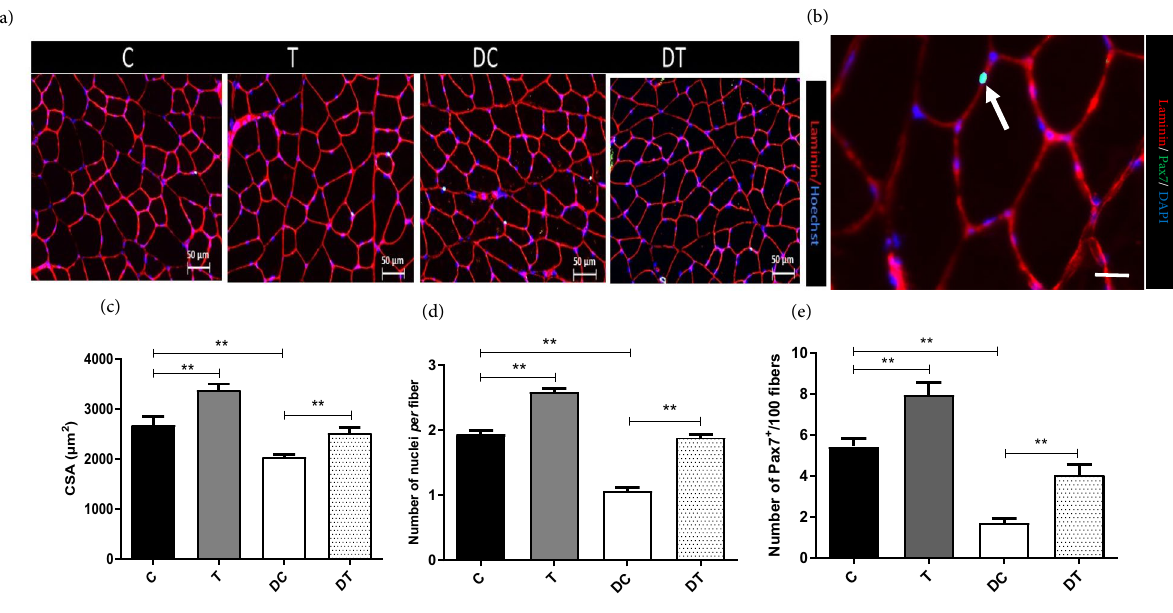
Figure 1. Muscle fiber cross-sectional area (CSA) and satellite cell content in different experimental groups. ( a ) Sections of gastrocnemius muscles immunolabeled for Laminin (red) and Hoechst (blue). ( b ) Representative image of satellite cell showing Laminin (red), Pax7 (green) and myonuclei (blue). ( c ) Average gastrocnemius muscle CSA and ( d ) myonuclei numbers. ( e ) Number of Pax7 + /100 fibers. White bar = 50 µm. **p < 0.001. Statistical analysis was performed using the Graph-Pad Prism statistics software (Graph-Pad Software Inc., San Diego, CA, USA free demo version